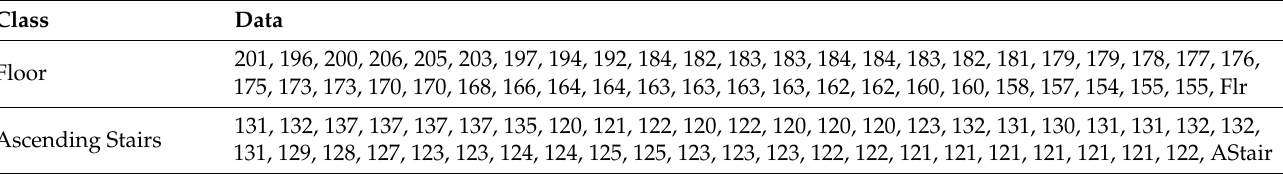
Table 3. Examples of data for different